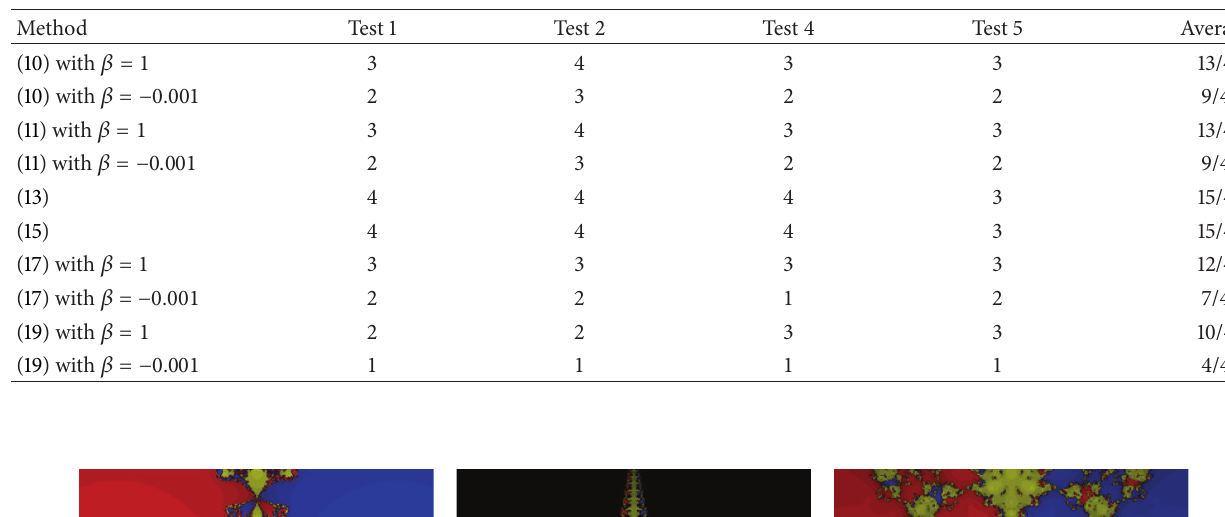
Table 1: Results of chaotic comparisons for different derivative-free methods.